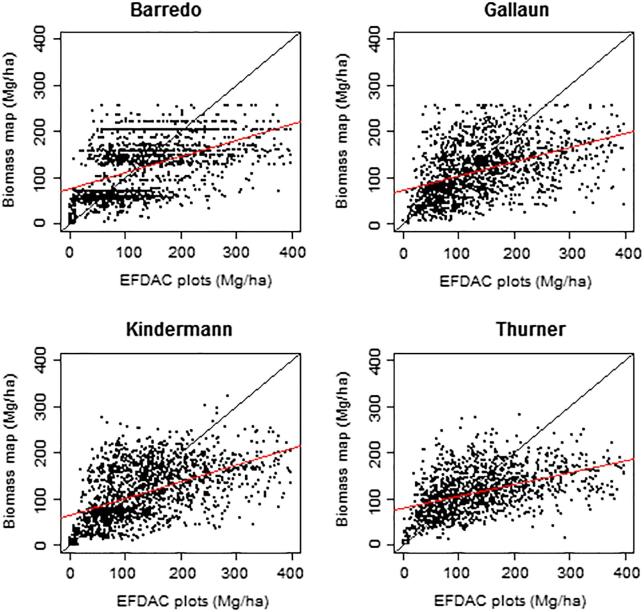
Comparison of the biomass maps with the selected EFDAC plot dataset. The red lines represent the linear regressions between the two datasets and the black lines represent the 1:1 line. (For interpretation of the references to color in this figure legend, the reader is referred to the web version of this article.)